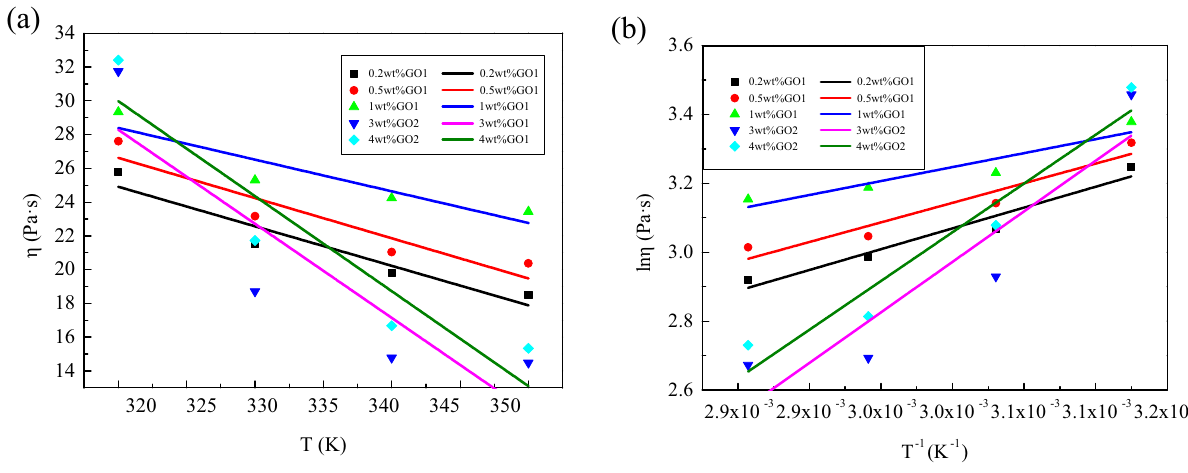
Figure 8: ( a ) The apparent viscosity – temperature curve ( γ = 1 s − 1 ) and ( b ) the ln η ∼ T − 1 curve ( γ = 1 s − 1 ) of blended solutions with di ff erent GO contents.